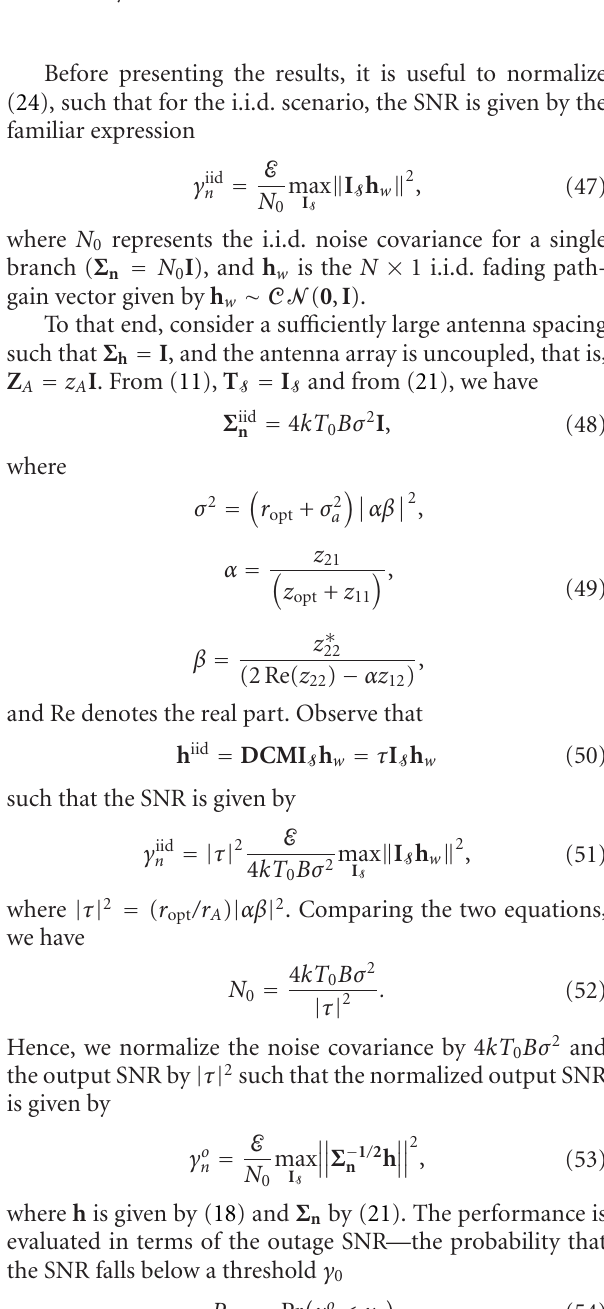
Figure 5: Configurations: (a) uniform linear array, (b) uniform circular